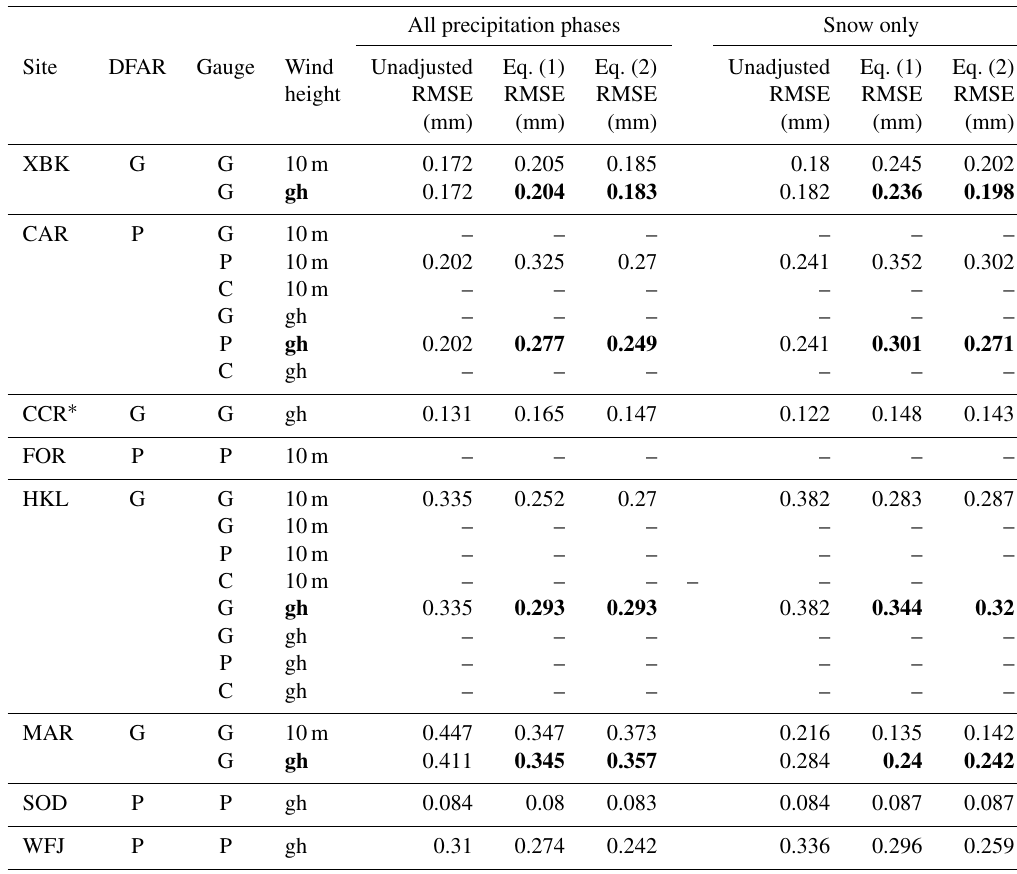
Table 5. Root mean square error (RMSE) for the unshielded gauges (G – Geonor; P – Pluvio 2 ) as compared to the DFAR reference at each site for the combined winters of 2015/2016 and 2016/2017 for available wind speed measurement heights (10m; gh – gauge height) and for Eqs. (1) and (2). Metrics are separated by precipitation phase (all and snow only). Where both wind speed heights are available, the gauge height data are shown in